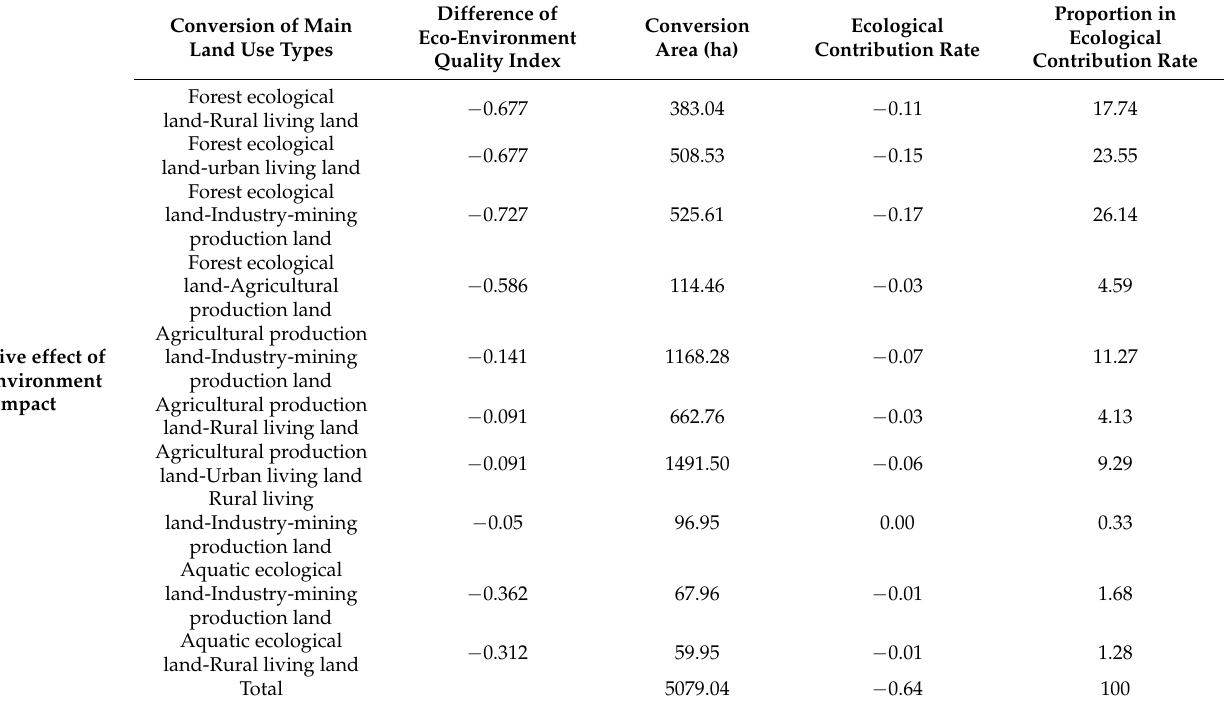
Table 5. Land-type conversion of LUFT and its contribution rate to the eco-environment quality of Haikou from 2009 to